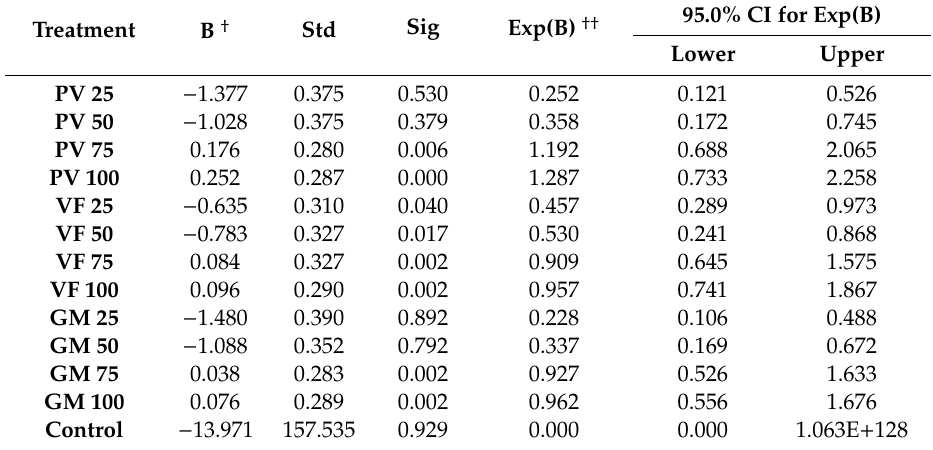
† B: B values are associated with increased hazard and decreased survival time; as the predictor increases, the hazard of the event increases and the predicted survival duration decreases. Negative coe ffi cients indicate decreased hazard and increased survival times. †† Exp(B): the ratio of hazard